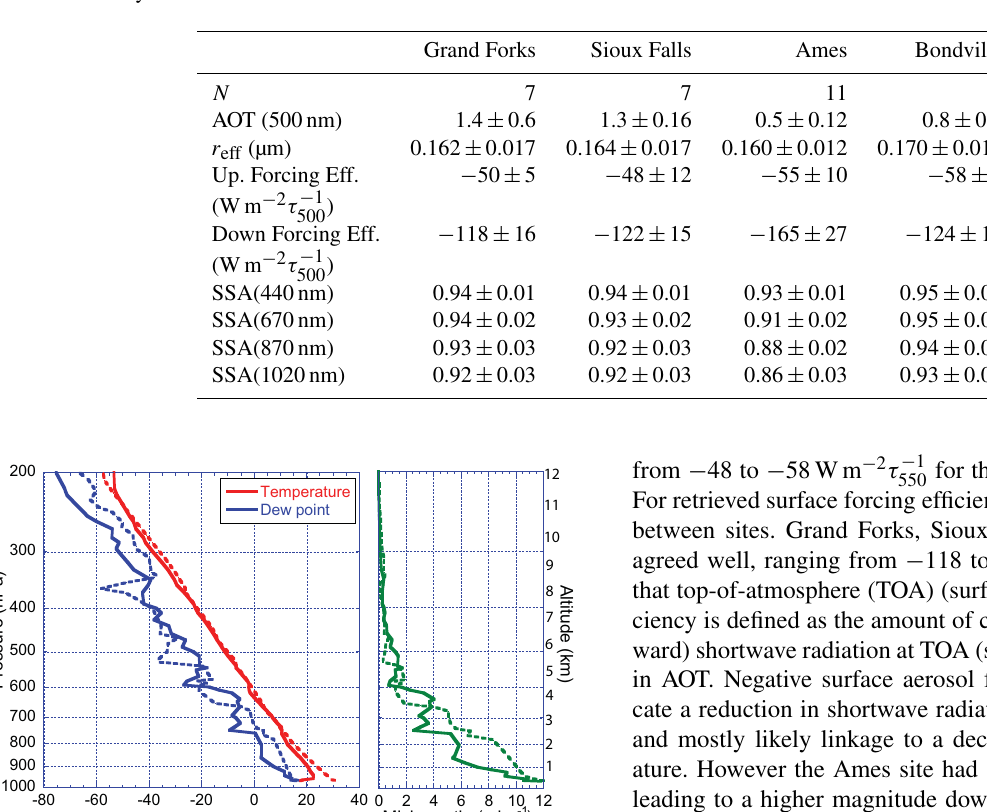
on 30 June. Each data point in Fig. 3a, c, and e represent